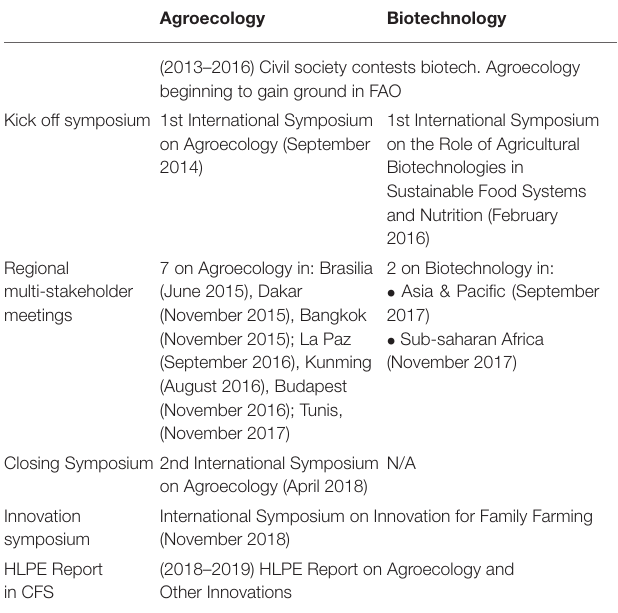
TABLE 2 | Timeline of key FAO moments regarding agroecology and innovation. Source: interviews, FAO (2018).